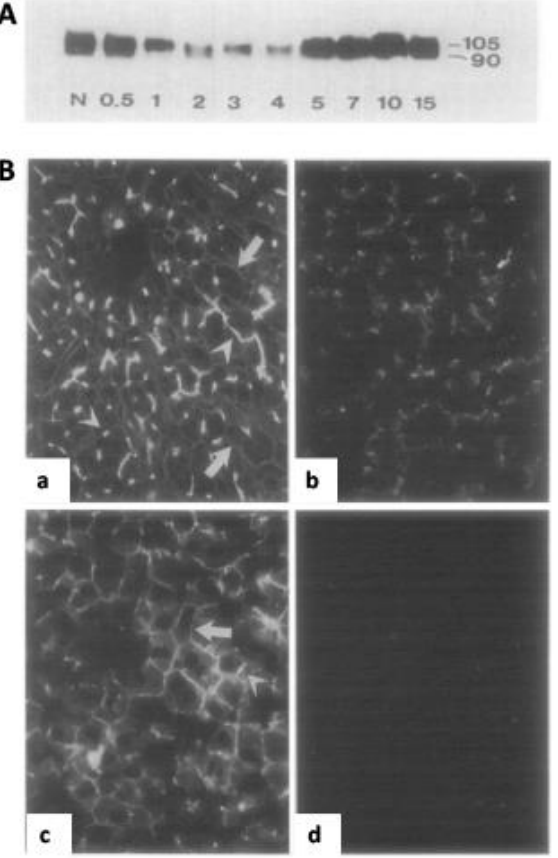
Figure 2. Dynamic expression of CEACAM1 in regenerating rat livers after partial hepatectomy. ( A ) A Western Blot showing CEACAM1 expression before (N) and after partial hepatectomy at the indicated timepoints (days) in rats. The decline in CEACAM1 expression starts 1 day after the procedure and returns back to near normal levels approximately after 7–10 days. ( B ) Analysis of CEACAM1-expression by indirect fluorescence (white signals) in a healthy rat liver ( a ), 48 h ( b ), and 15 days ( c ) after partial hepatectomy. CEACAM1 is expressed on all membranes of the hepatocytes with especially strong staining present at the apical surface of the hepatocytes. Weaker staining is present on the hepatocellular surface facing the sinusoidal space (a,c: white arrows). ( d ) negative control. ( A , B ) reprinted with modifications from [53] with permission from Elsevier.